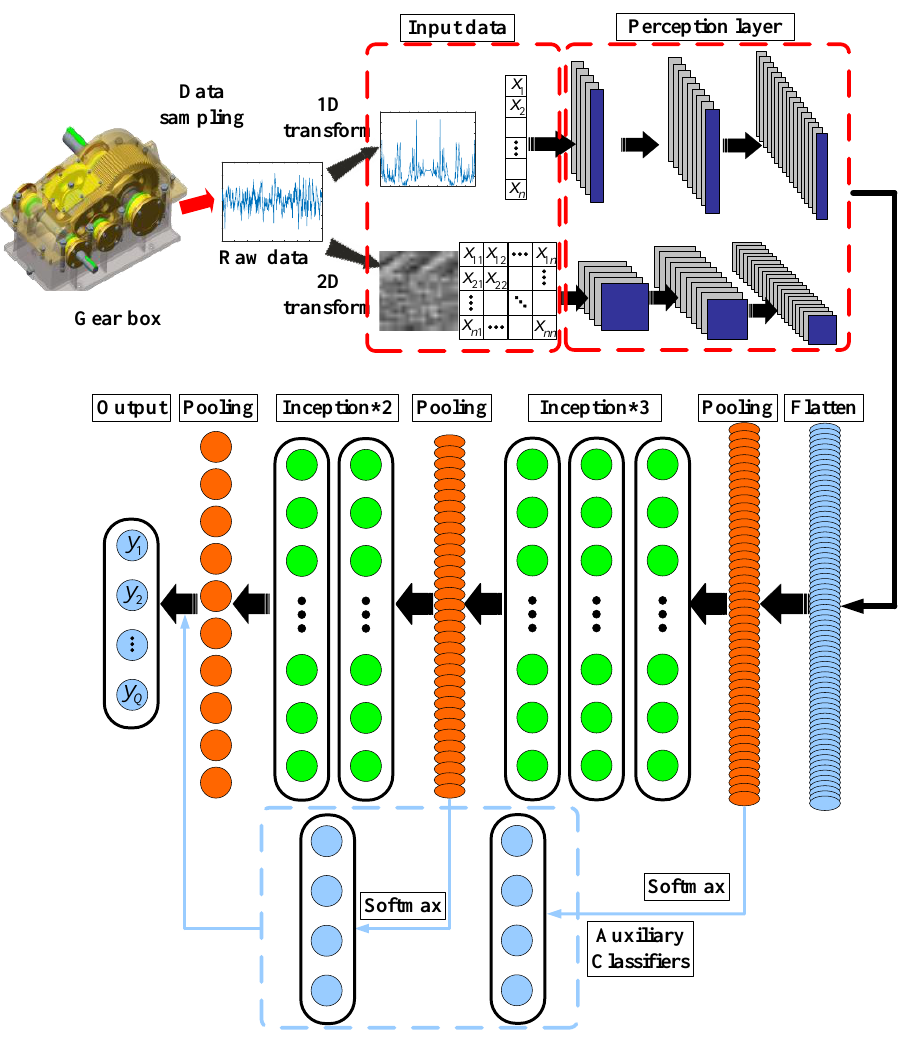
Figure 2. AF-CDN structure diagram.